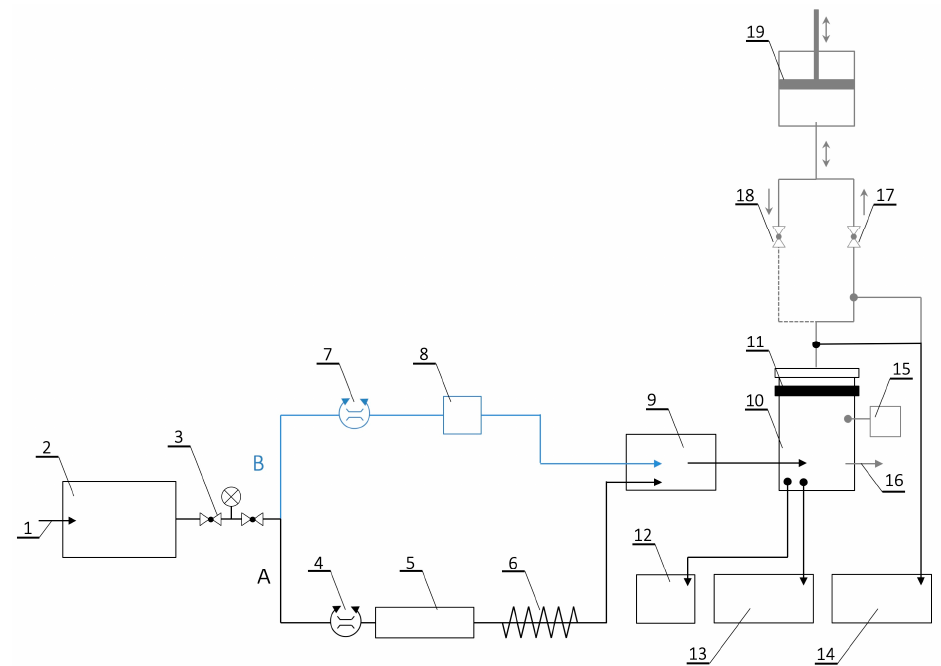
Figure 2. Diagram of breakthrough testing stand: 1—compressed air; 2—dust filter; 3—pressure